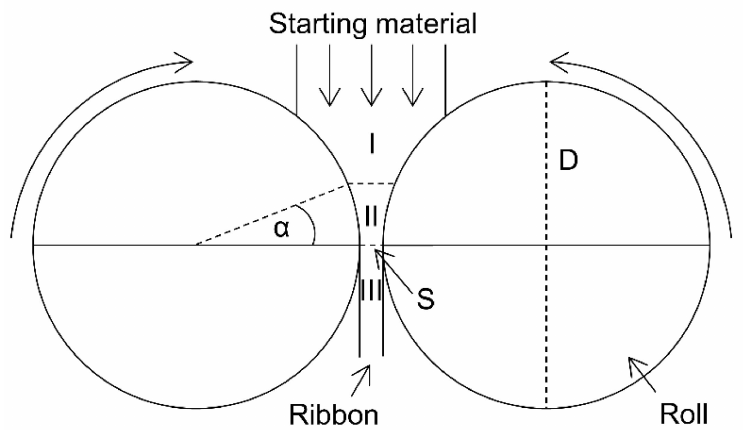
Figure 1. Schematic presentation of roll compaction with slipping zone (I), compaction one (II), release zone (III), roll diameter ( D ), gap width ( S ) and nip angle ( α